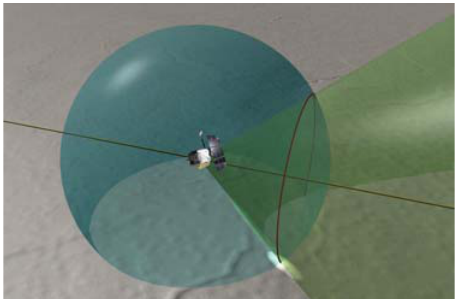
Figure 2a. Cartoon illustrating the geometry of monostatic radar imaging. Features are located in terms of their range from the spacecraft and Doppler shift at the time of observation. Range (blue sphere and Doppler (green cone) surfaces intersect in a circle (red). This intersects the planetary surface at two points, only one of which is illuminated. As discussed in the text, monostatic radar images are typically obtained by viewing perpendicular to the trajectory (near zero Doppler shift) rather than “squinted” as shown here.